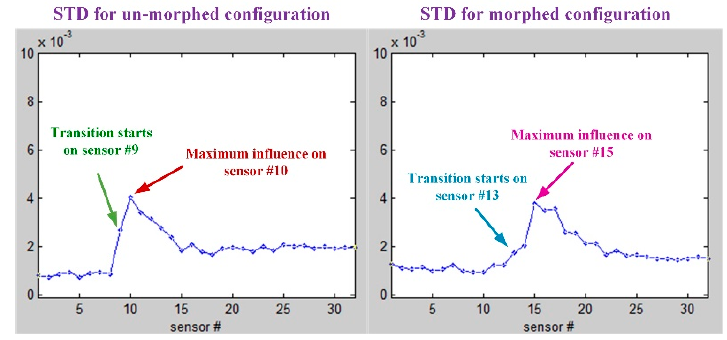
Figure 20. Standard deviation (STD) results for M = 0.2, α = 2 ˚ , and δ = 4 ˚ flow conditions.